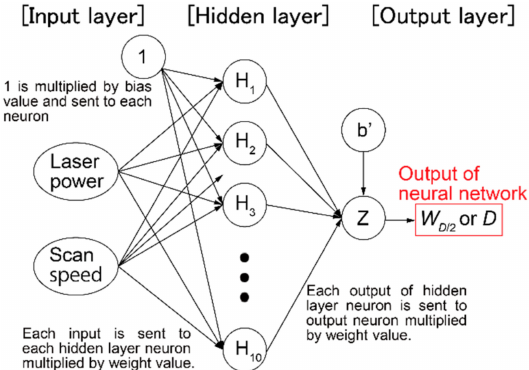
Figure 9. Neural network for predicting melt pool dimensions used in this